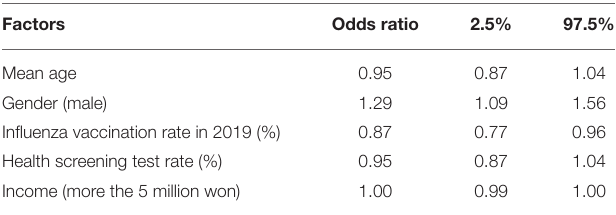
TABLE 2 | Odds ratios and 95% credible intervals of having COVID-19 clusters with more than 20 cases by Bayesian conditional autoregressive (CAR) model.